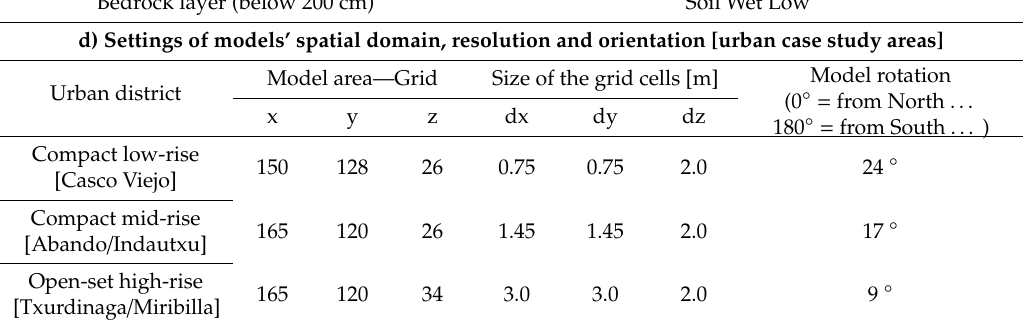
Table 7. Materials setting applied in the ENVI-met